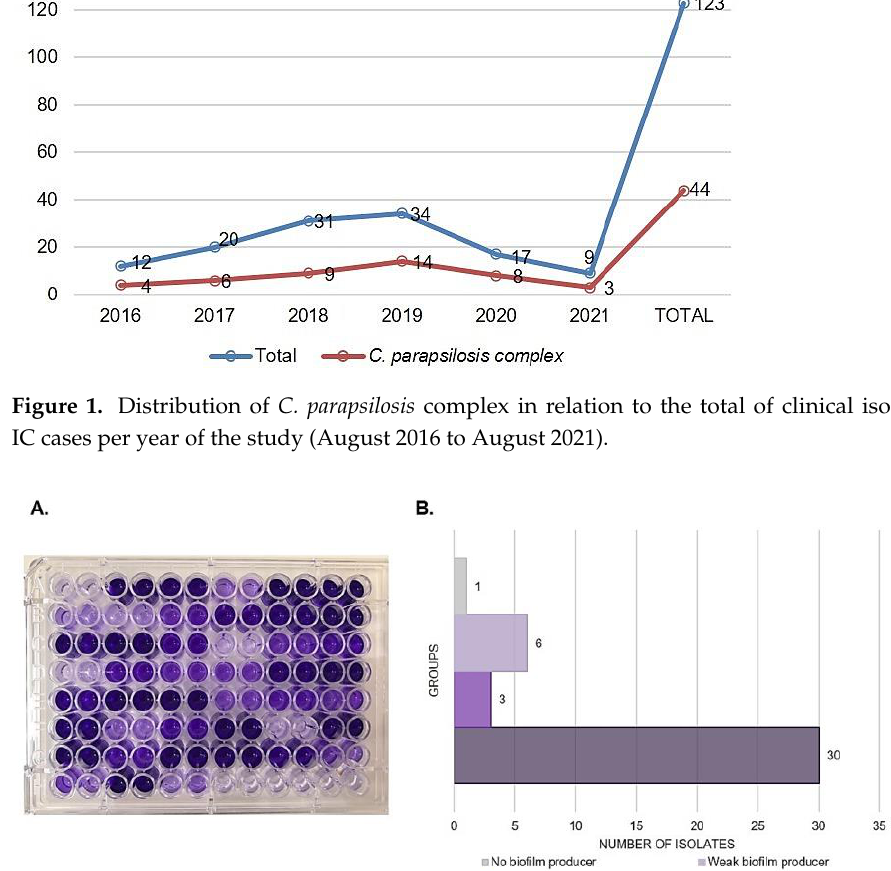
Figure 2. Total biofilm biomass quantified by crystal violet staining in 96-well microtiter plate ( A ). Distribution of C. parapsilosis sensu stricto isolates by biofilm production groups ( B ).